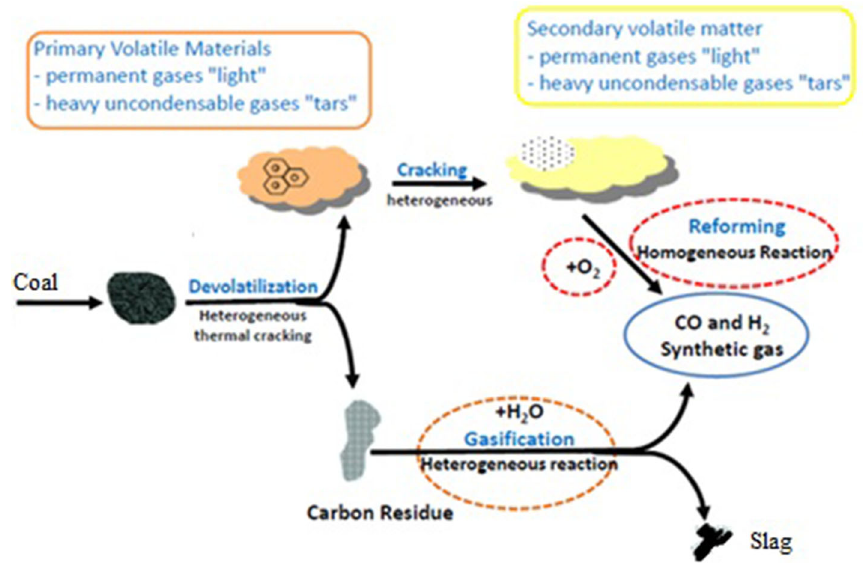
Fig. 2 Simplified overview of the various mechanisms involved in the gasification